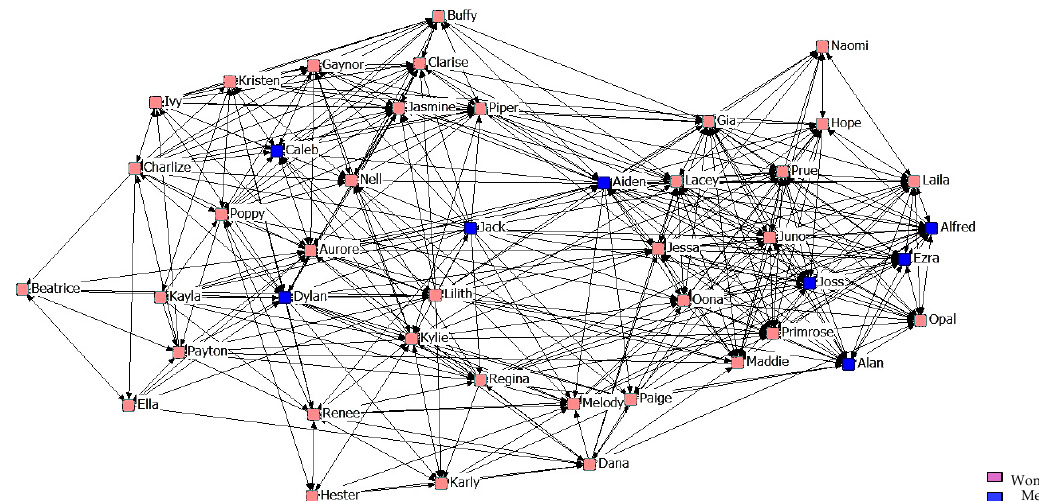
Figure 8. Graph of the second year Intermediate Friendship Network.